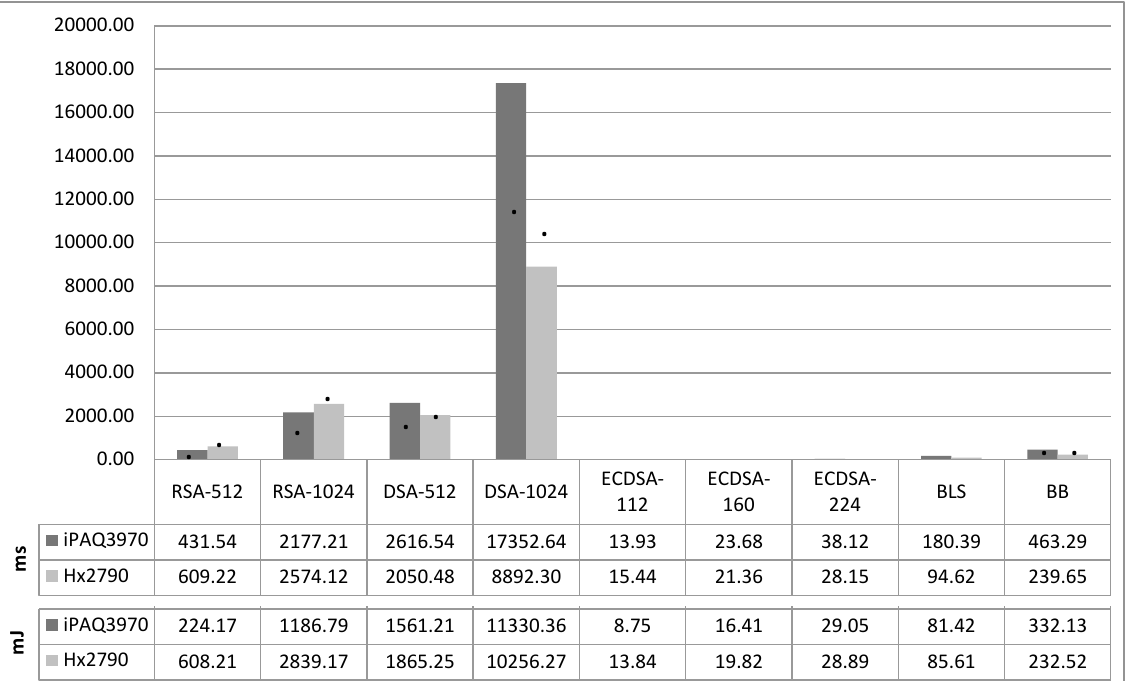
Figure 4. Temporal costs (represented with bars) and Energy costs (represented with dots) of asymmetric key generation